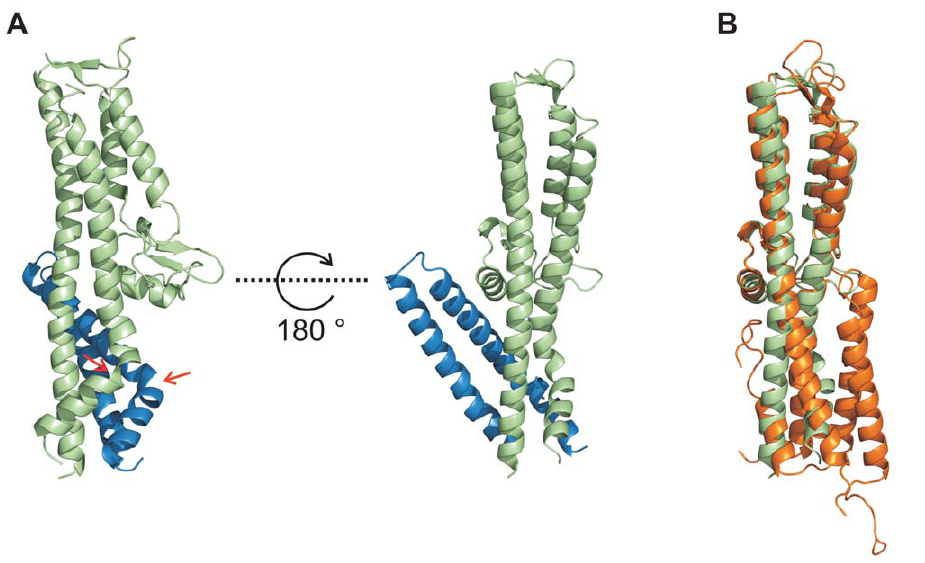
Figure 3. Conformational changes during interaction of SipD and PrgI. (A) Structure of the PrgI-SipD D D1 fusion protein (SipD green and PrgI blue) from two orthogonal perspectives. The helix kink in SipD and PrgI is indicated by red arrows. (B) Superposition of complexed SipD (green) with monomeric SipD (orange) indicated conformational changes in the central coiled coil.